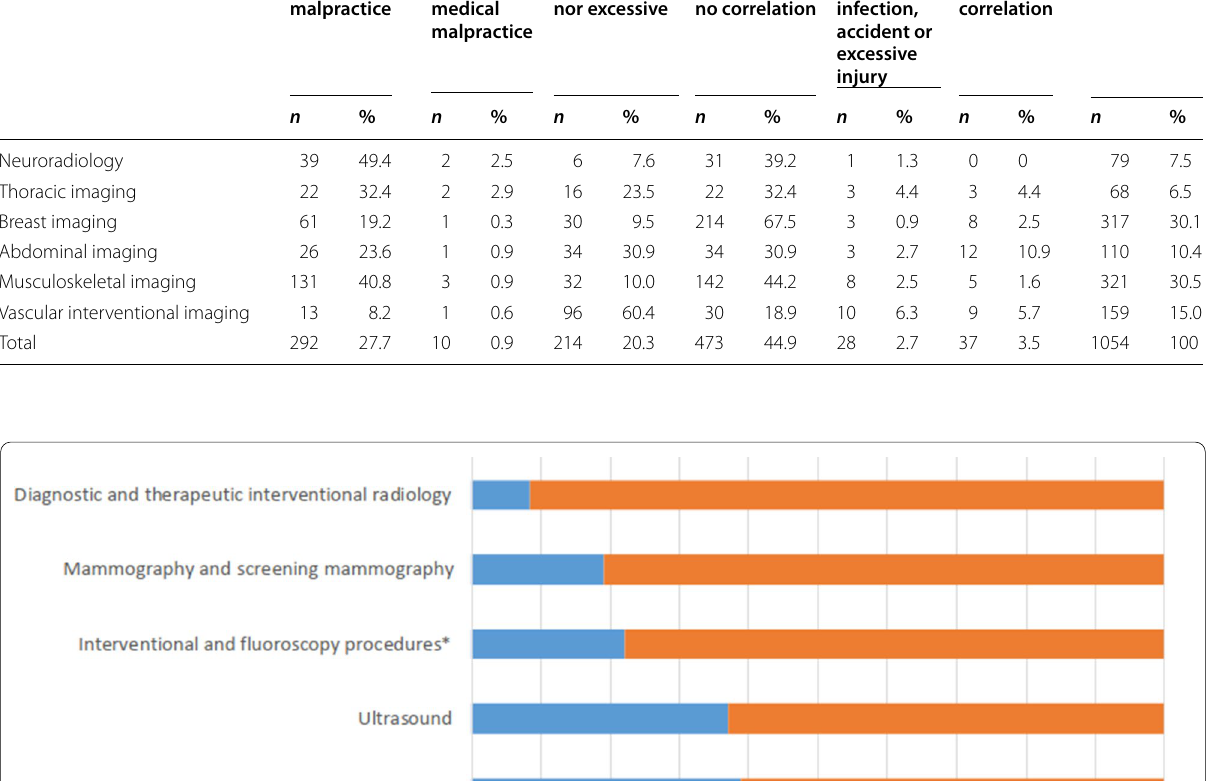
radiology (75.3%), as well as ‘Complication, infection or other harm’ (34.8%). ‘Pain but no effect on treatment or prognosis’ (69.2%) and ‘Deteriorated prognosis or delayed cancer treatment’ were general in mammography screening (66.7%), and ‘Aches and pains’ were typical in radiography (63.2%). ‘No major harm, or no correlation with medical care’ was most commonly associated with all modalities (38%).